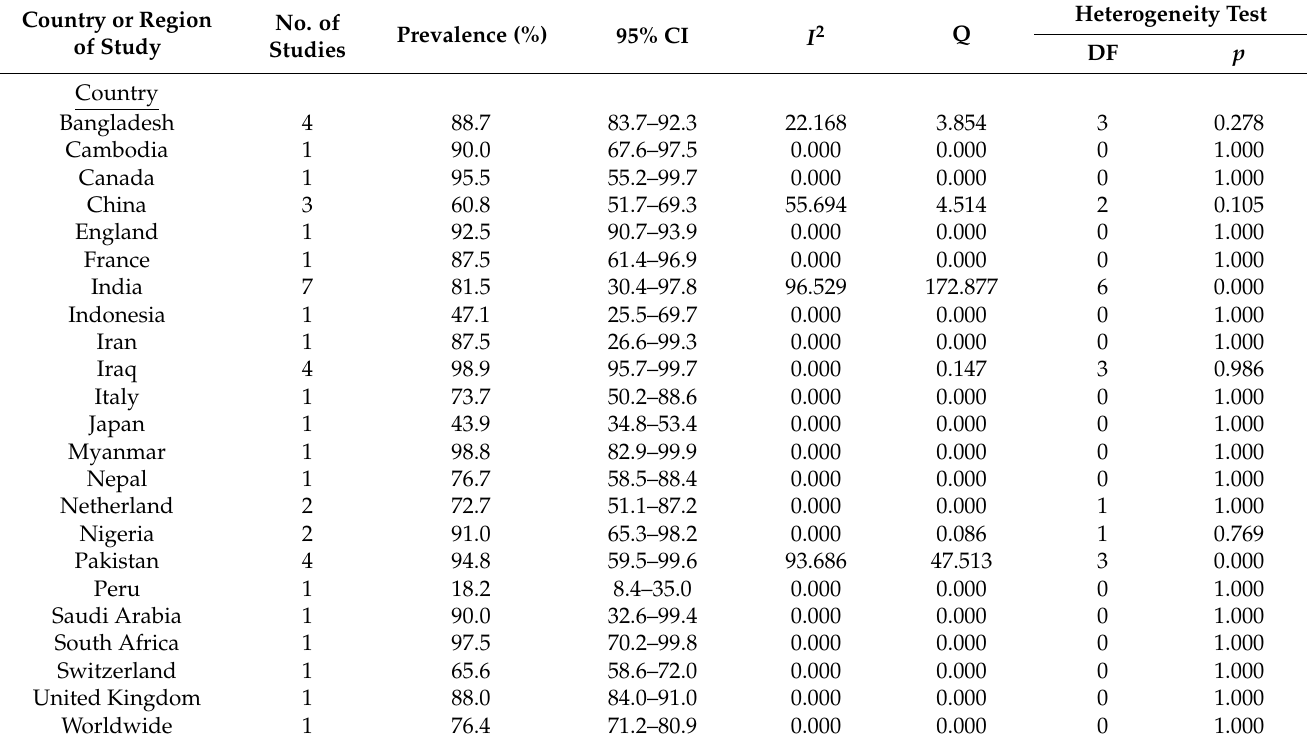
Table 2. Sub-group analysis of prevalence of resistant S. Typhi according to countries and